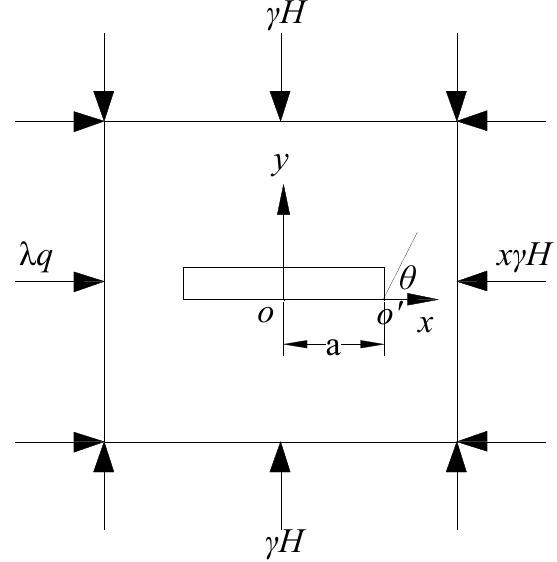
Figure 8. Mechanical model based on elastic-plastic theory.